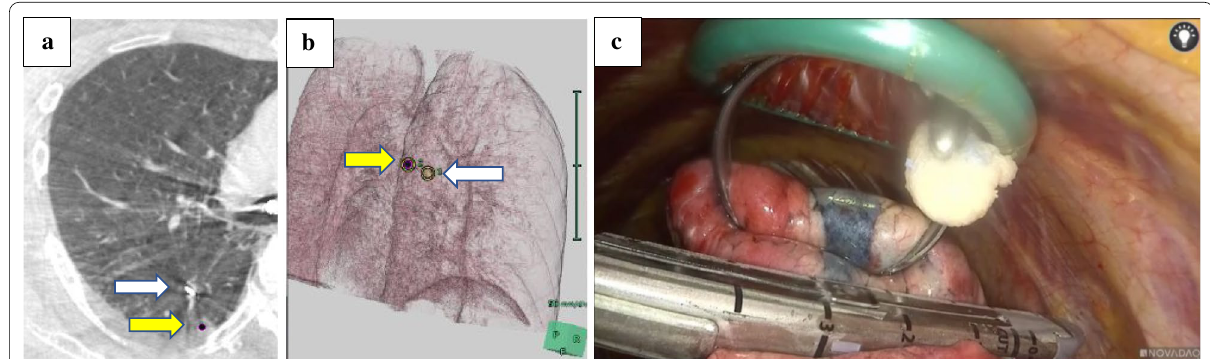
Fig. 2 Intraoperative findings of thoracoscopic wedge resection using cone beam computed tomography (CT) in a hybrid surgical theater. a Intraoperative CT image. The yellow arrow indicates the tumor shadow position, and the white arrow denotes the tip of the injection catheter advanced through a working channel of a flexible bronchoscopy. b Three-dimensional positional relationship between the tumor (yellow arrow) and the marking spot on the pleural surface (white arrow), which was reconstructed in a surgical room. c Wedge resection was performed using a linear